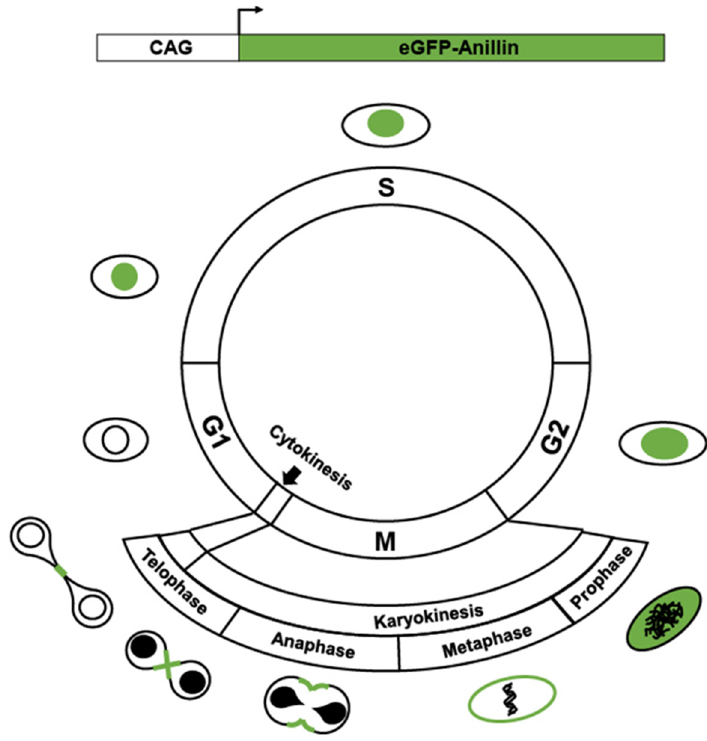
Figure 5. CAG-eGFP-Anillin . The subcellular localization of constitutive expression of eGFP-Anillin marks cells that undergo cytokinesis by labeling the mid-body. Figure adapted from Hesse, M. et al., Nat Commun 2012, 3, 1076.